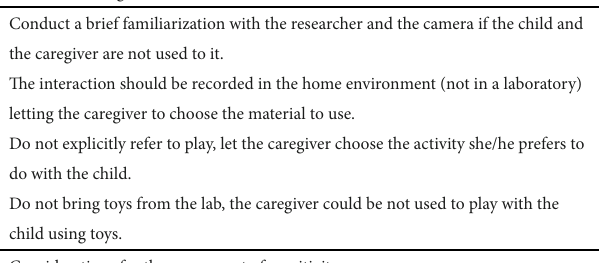
TABLE 3 Guidelines for assessing sensitivity in low-income populations.